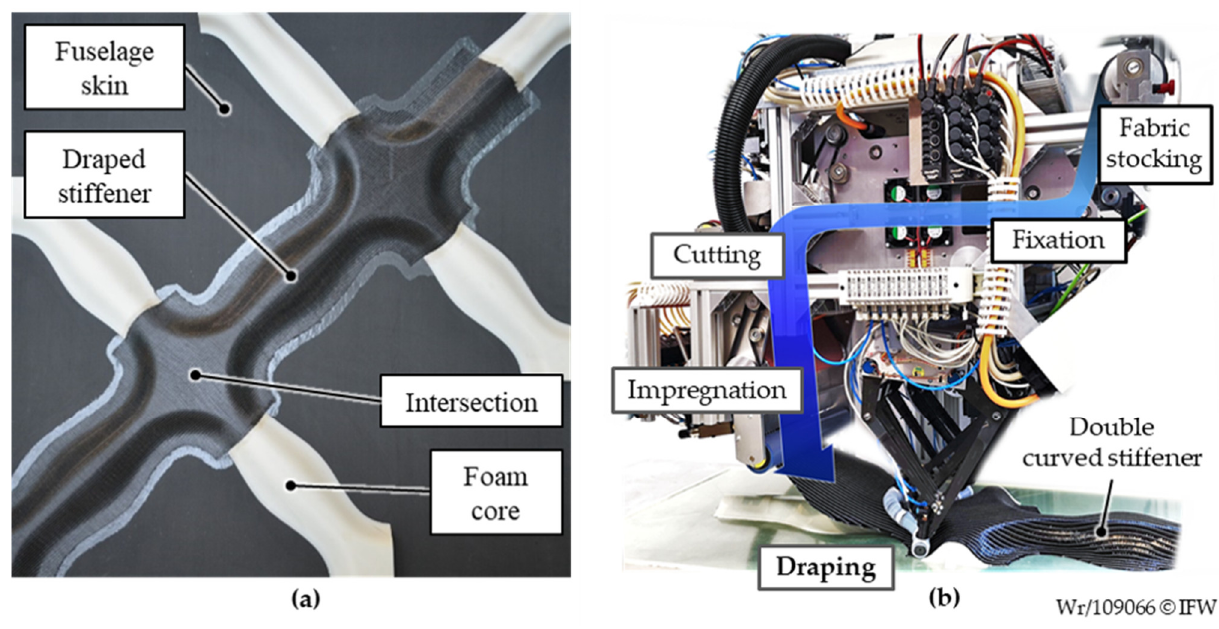
Figure 1. ( a ) Unconventionally stiffened lattice composite fuselage panel; ( b ) robot end-effector for continuous wet drap- ing.